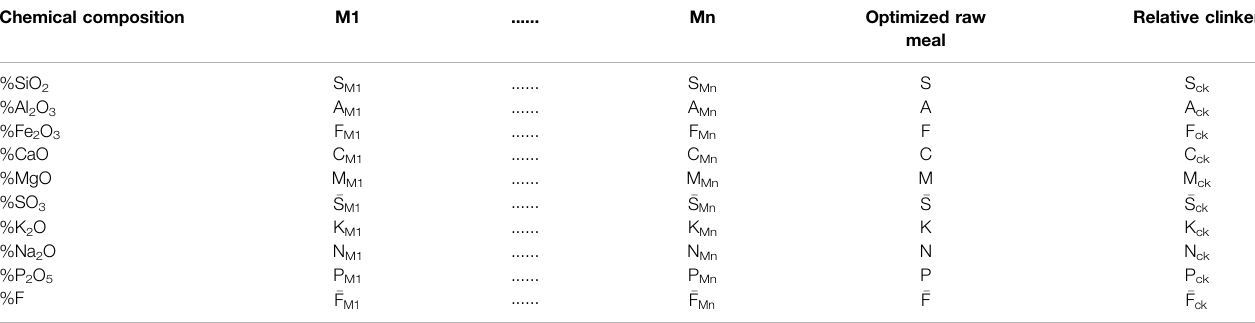
TABLE 3 | Adopted designations used to explain the raw meal (raw mix) calculation program. Chemical